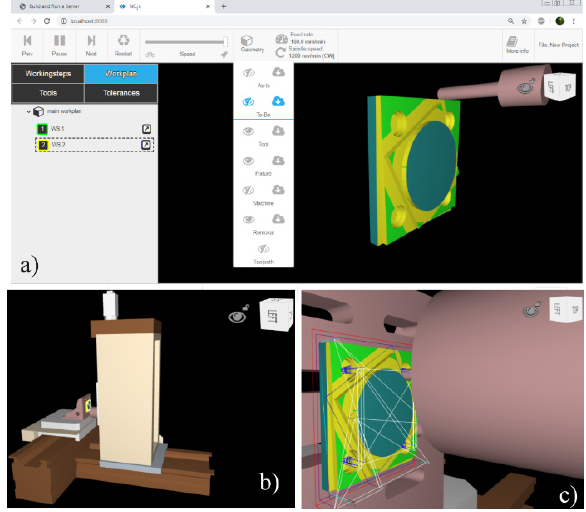
Figure 11. Configured LOLA HBG80 virtual machine tool in a WEB environment on local